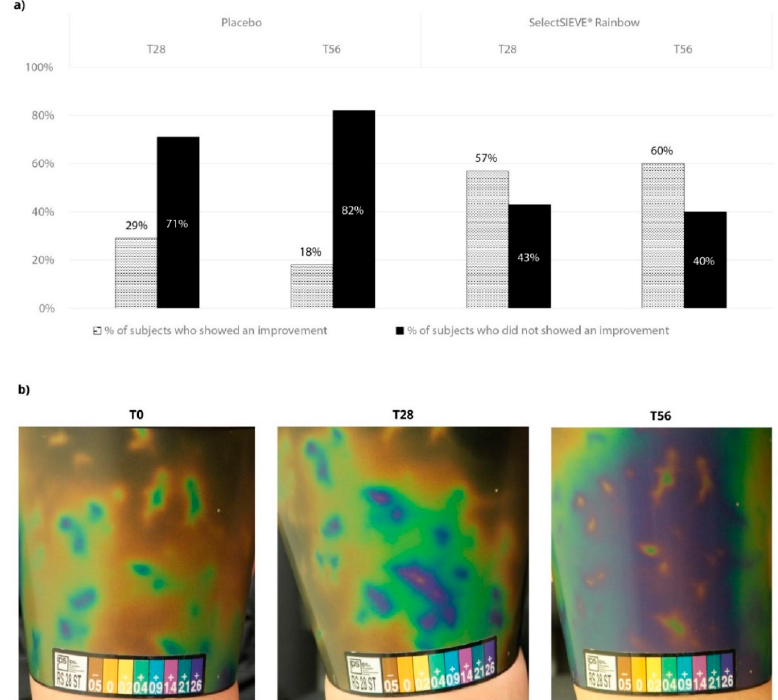
Figure 5. Evaluation of skin microcirculation: ( a ) The graph shows the percentage of subjects, belonging to the placebo and the SelectSIEVE ® Rainbow group, who showed or did not show an improvement based on clinical evaluation of thermographic analysis. ( b ) The figure shows the microcirculation improvement by thermographic analysis of subject 22. Thermographic evaluations are performed at the level of the thighs and scored by the dermatologist in relation to the extent of the local variations of the temperature in the thermographic